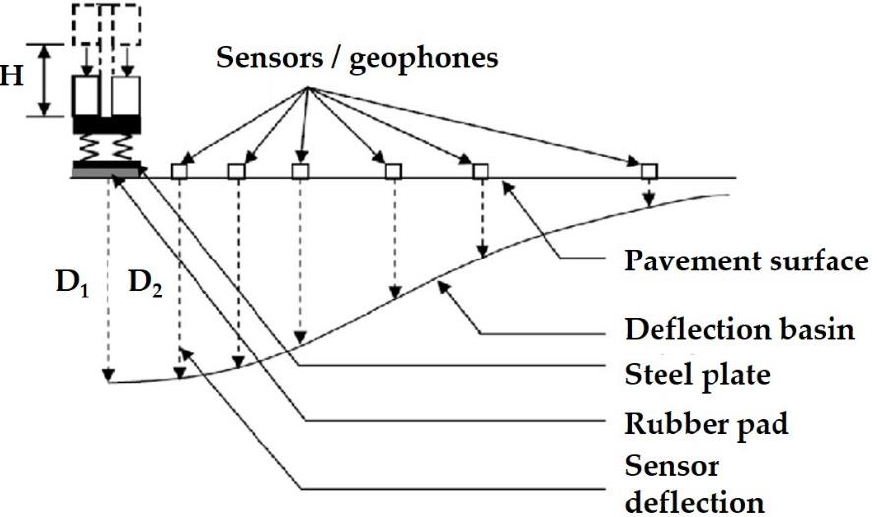
Figure 2. Operation principles of Falling Weight Deflectometer (FWD). Table 1. Deflection-Based Parameters